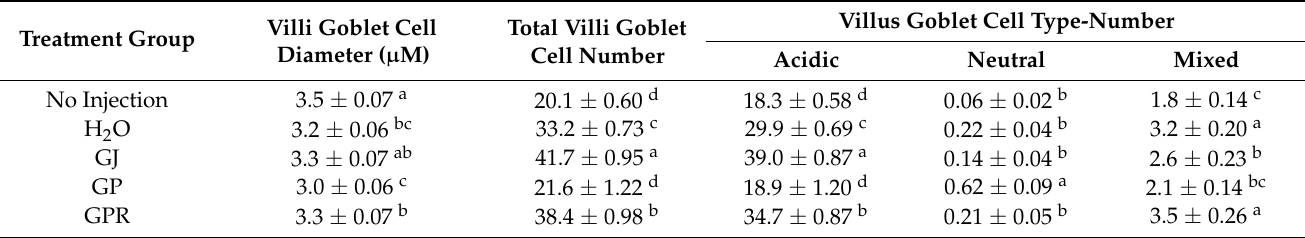
Table 5. Effect of the intra-amniotic administration of grape juice (GJ), pomace (GP), and puree (GPR) on the duodenal villus goblet cell type, number, and